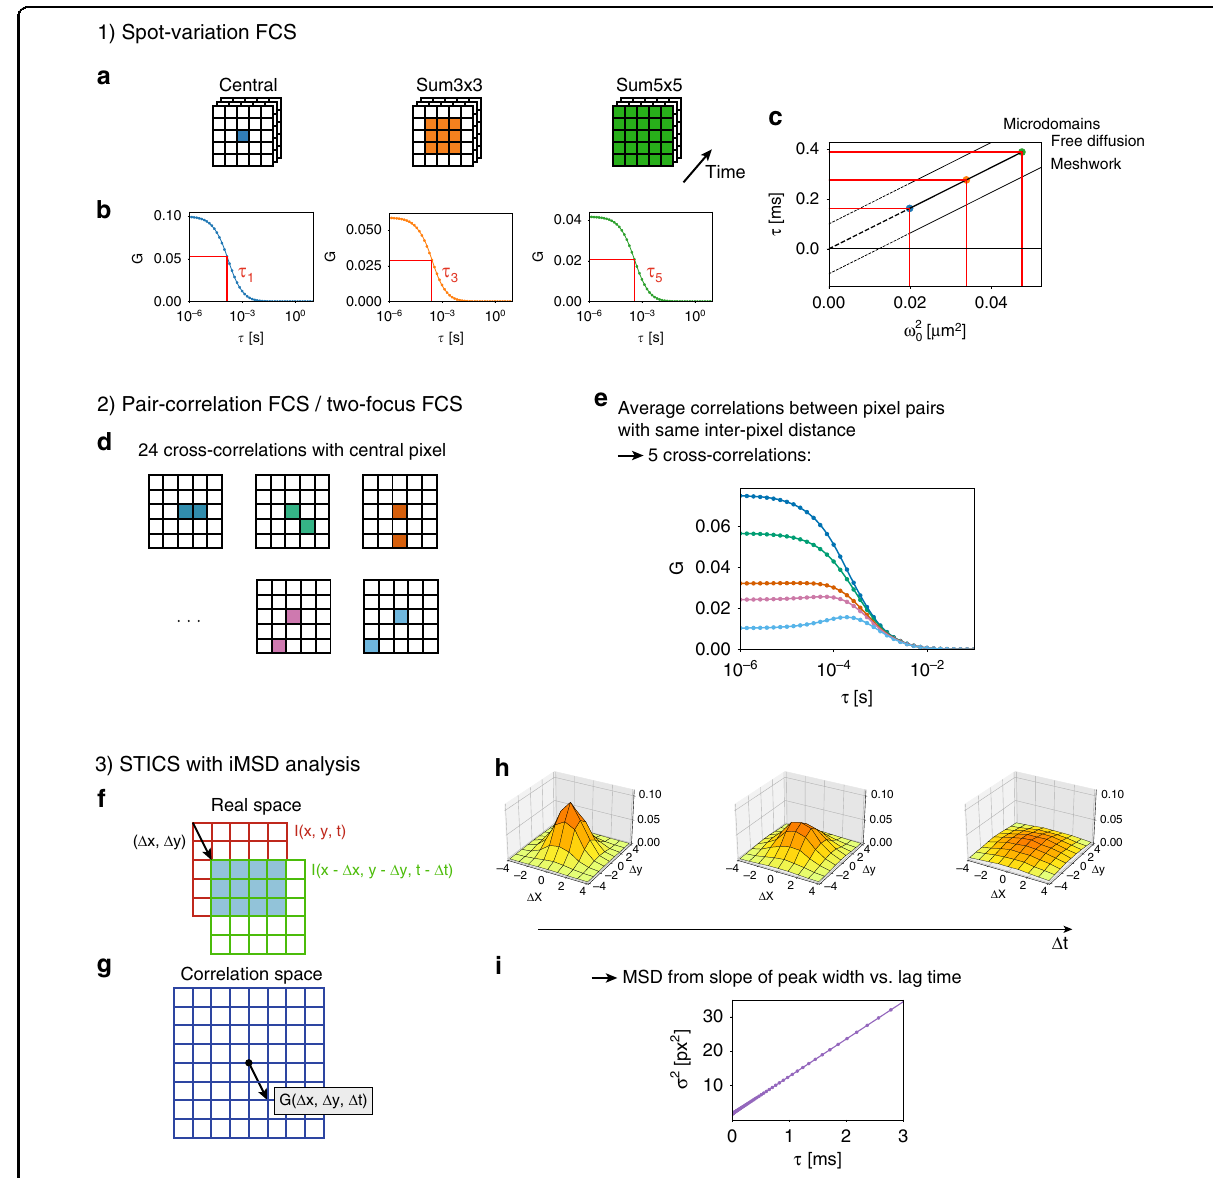
Fig. 2 Overview of the analysis techniques (1) spot-variation FCS, (2) pair-correlation analysis, and (3) spatio-temporal image correlation spectroscopy (STICS) with image-derived mean squared displacement (iMSD) analysis. In spot-variation FCS, a the signal from different pixels is summed for each frame, b the correlation curves of the corresponding time traces are calculated and fi tted, and c the resulting diffusion times τ are plotted as a function of the beam waist ω 0 2 . Free diffusion yields a directly proportional relationship between τ and ω 0 2 . Microdomains in the sample yield a positive intercept, τ (0) > 0, diffusion through a meshwork yields a negative intercept, τ (0) < 0. In two-focus FCS with pair-correlation analysis, d all 24 cross-correlations between the central pixel and the other pixels are calculated. e Cross-correlations between pixel pairs with the same interpixel distance are averaged, and the resulting 5 curves are simultaneously fi tted in a global fi t. f For STICS with iMSD analysis, each 5 × 5 frame is treated as an image. g , h The images are correlated in space and time, resulting in a series of 9 × 9 matrices. For free diffusion, the surface plots of these matrices show a Gaussian function of which the amplitude decreases and the width ( σ 2 ) increases linearly for increasing lag times. i The diffusion coef fi cient can be derived from the slope of the curve σ 2 ( τ